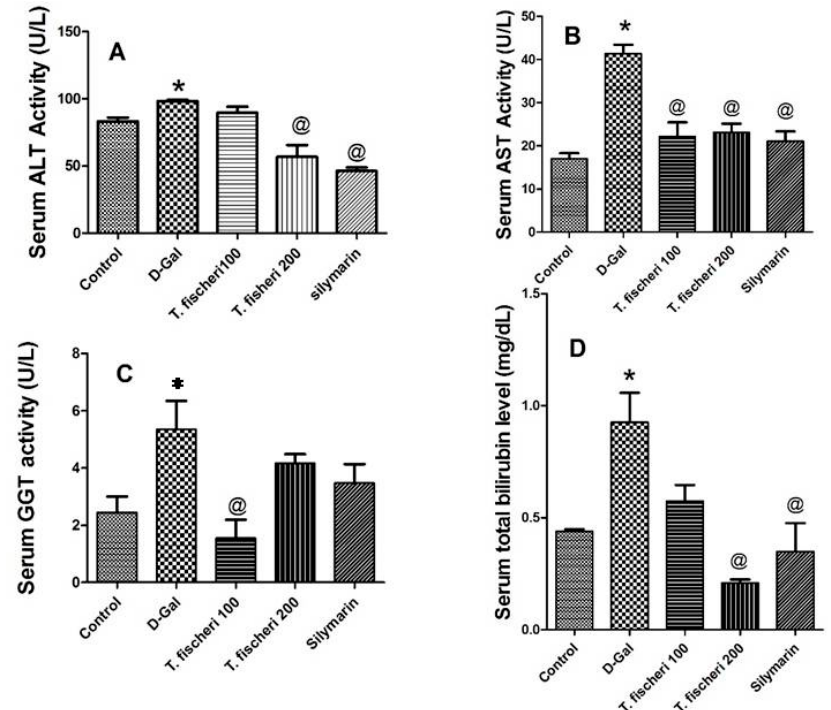
Figure 9. Influence of a single oral dose of D -galactosamine—induced liver injury (800 mg/kg) and oral administration of two doses (100 mg/kg and 200 mg/kg b.w.) of T. fischeri extract and the positive control silymarin (100 mg/kg) on serum enzyme activities ( A ) alanine aminotransferase (ALT); ( B ) aspartate aminotransferase (AST); ( C ) gamma-glutamyltransferase (GGT); ( D ) Total bilirubin level. Results are expressed as mean ± SEM. * Significant difference compared to normal control group; @ Significant difference compared to D-GalN treated group at p < 0.05. n = 6; by One Way ANOVA and Tukey post hoc test.